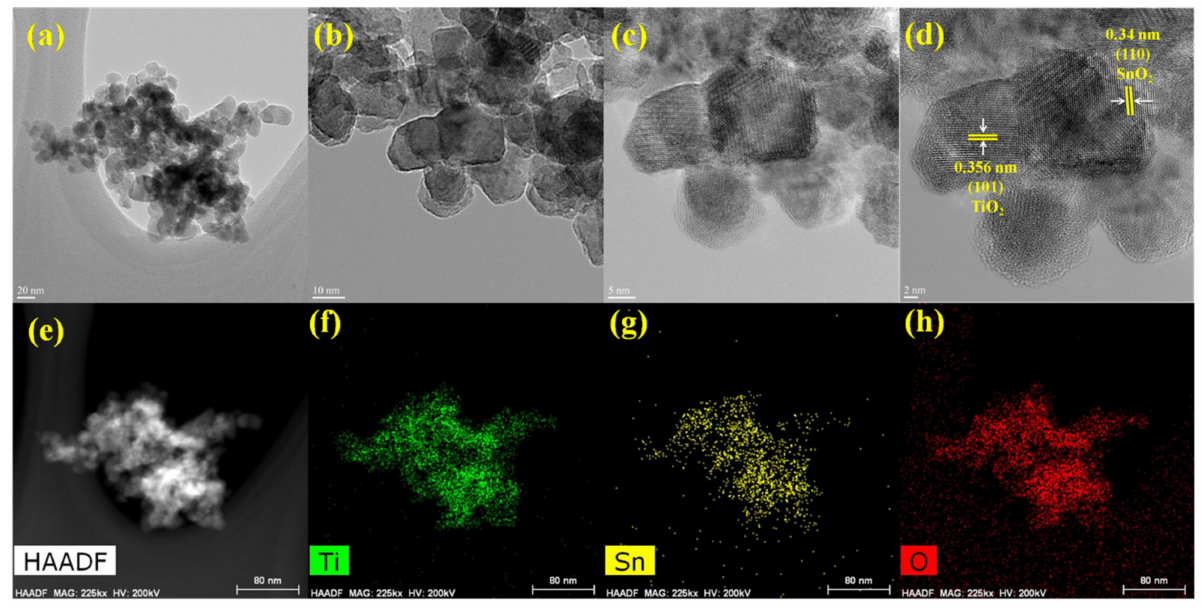
Figure 3. ( a , b ) TEM images of sample TSU80 at different magnification, ( c , d ) HRTEM of the TiO 2 – SnO 2 heterojunction region ( e ) HAADF image and ( f – h ) elemental mapping of TSU80